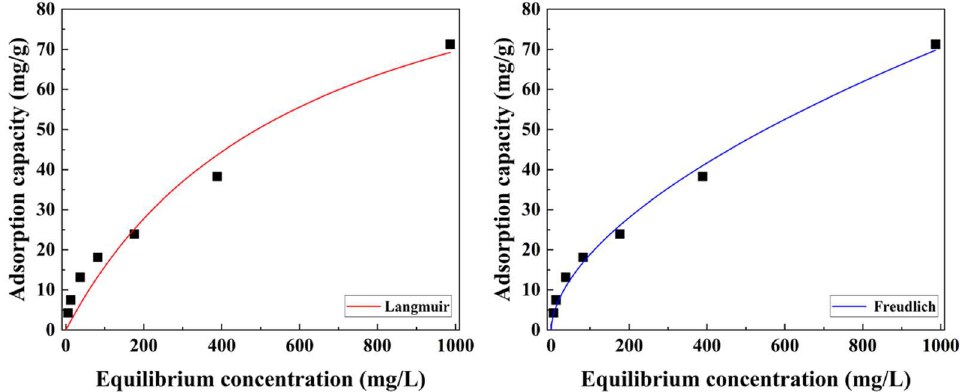
Figure 7. Iodide adsorption isotherm of Alg–BO and results of nonlinear fitting using Langmuir (red line) and Freundlich (blue line) models. Initial iodide concentration = 10–1000 mg/L; adsorbent concentration = 1 g/L; contact time = 24 h. Table 1. Isotherm fitting and kinetic fitting parameters of iodide adsorption by Alg–BO.